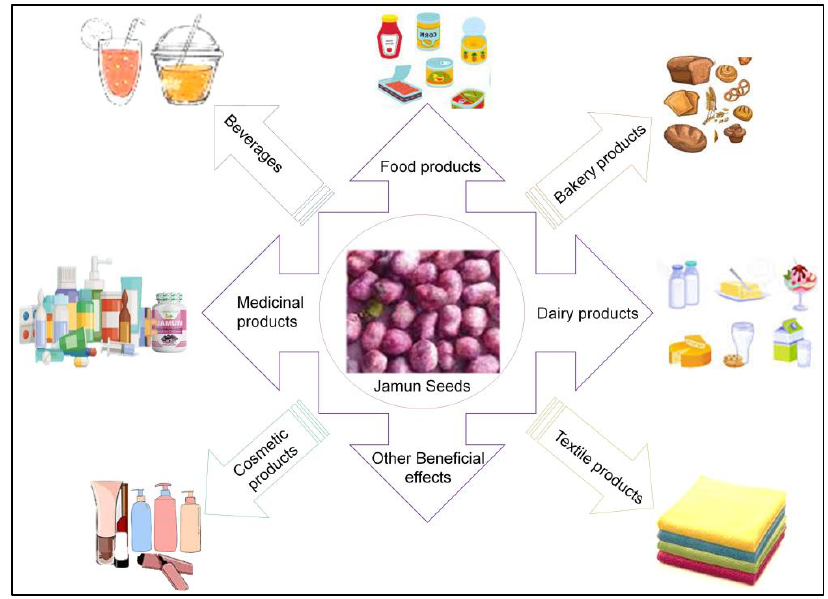
Figure 2. Multiple uses of Jamun seeds. Adopted and reproduced from Kumar et al. [10], under the